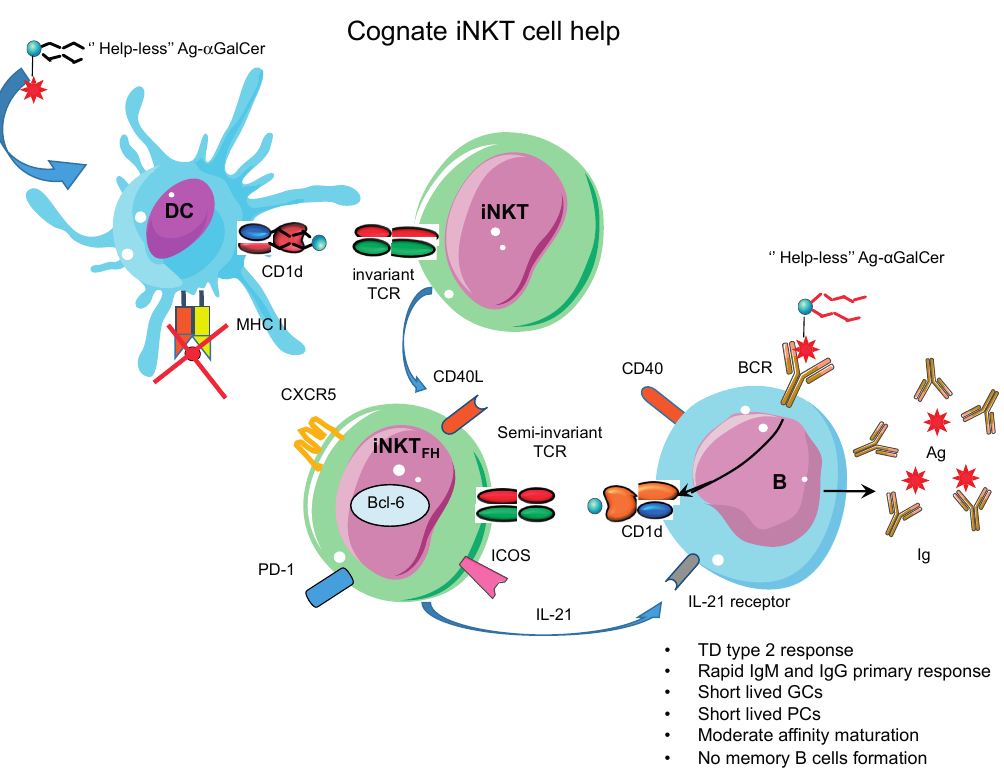
Figure 1. Cognate iNKT cell help for B-cell responses. iNKT cells provide direct